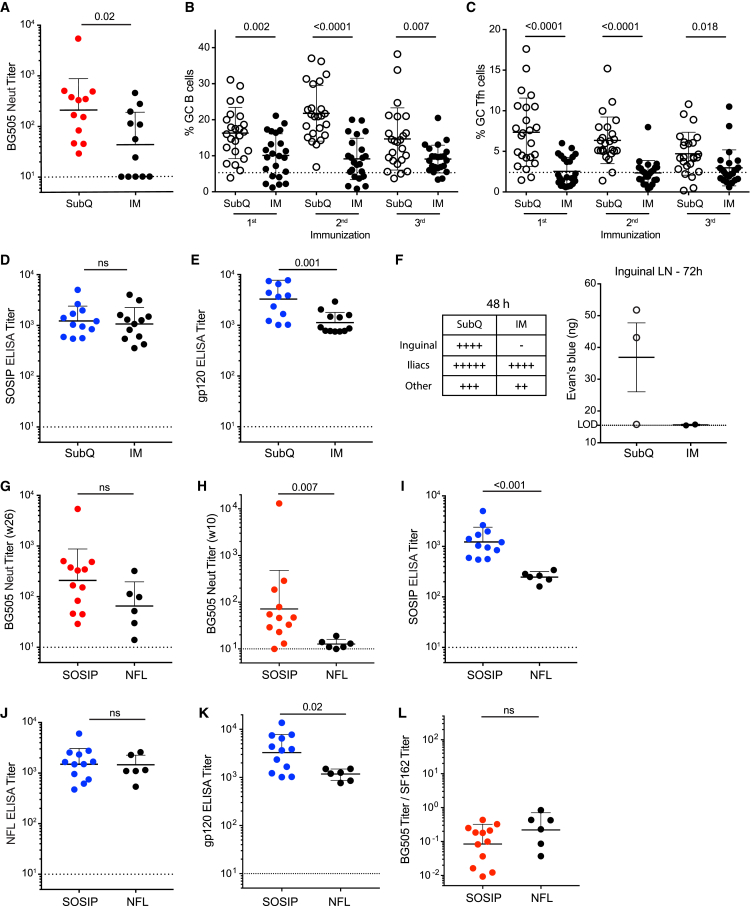
Subcutaneous Immunizations Induce Stronger Autologous nAb Responses Than Intramuscular ImmunizationsSOSIP.664 and NFL Env trimers have similar immunogenic properties.(A–F) Comparison of subcutaneous (s.c. or SubQ) and intramuscular (i.m. or IM) immunization routes with BG505 SOSIP.664 as immunogen. (A) BG505 nAb titers after BG505 SOSIP.664 s.c. or i.m. immunization (week 26; n = 12 animals per group). (B and C) GC B cell frequencies (B) and GC Tfh cell frequencies (C) 3 weeks after the first, second, and third s.c. or i.m. immunizations (n = 24 LNs per group). (D and E) BG505 SOSIP (D) and BG505 gp120 (E) IgG binding titers (week 26; n = 12). (F) Evans Blue dye drainage to LNs at 48 hr was scored by visual inspection (left). Dye accumulation in LNs at 72 hr was quantified by dye extraction (right).(G–K) Ab responses in RMs immunized with BG505 SOSIP.664 or BG505 NFL via s.c. injection. (G and H) BG505 nAb titers in BG505-SOSIP.664- and BG505-NFL-immunized RMs (n = 12 and 6, respectively) 2 weeks after the third (G) or second (H) immunization. (I–K) BG505 SOSIP (I), BG505 NFL (J), and BG505 gp120 (K) IgG binding titers 2 weeks after the third immunization (week 26; n = 6 or 12).(L) Ratio of BG505 to SF162 nAb titers 2 weeks after the third immunization (week 26; n = 6 or 12).All nAb titer and ELISA binding Ab data represent geometric mean titers with geometric SD. All cell-frequency data represent the mean and SD. The Evans blue quantification shows mean with SEM. See also Figure S2.